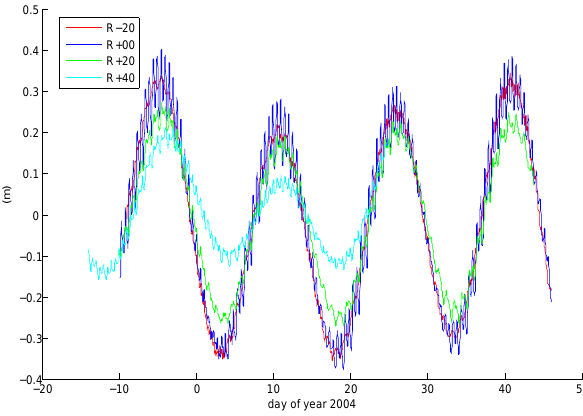
Fig. 1. Linearly detrended in-line displacements on Rutford Ice Stream, West Antarctica. Displacements are shown at locations along the medial line at a distance of 20km downstream of the grounding line (R–20), at the grounding line (R+00), and at dis- tances of 20 and 40km upstream from the grounding line (R+20 and R+40, respectively). The displacement curves shown are based on a tidal fit to the original measured